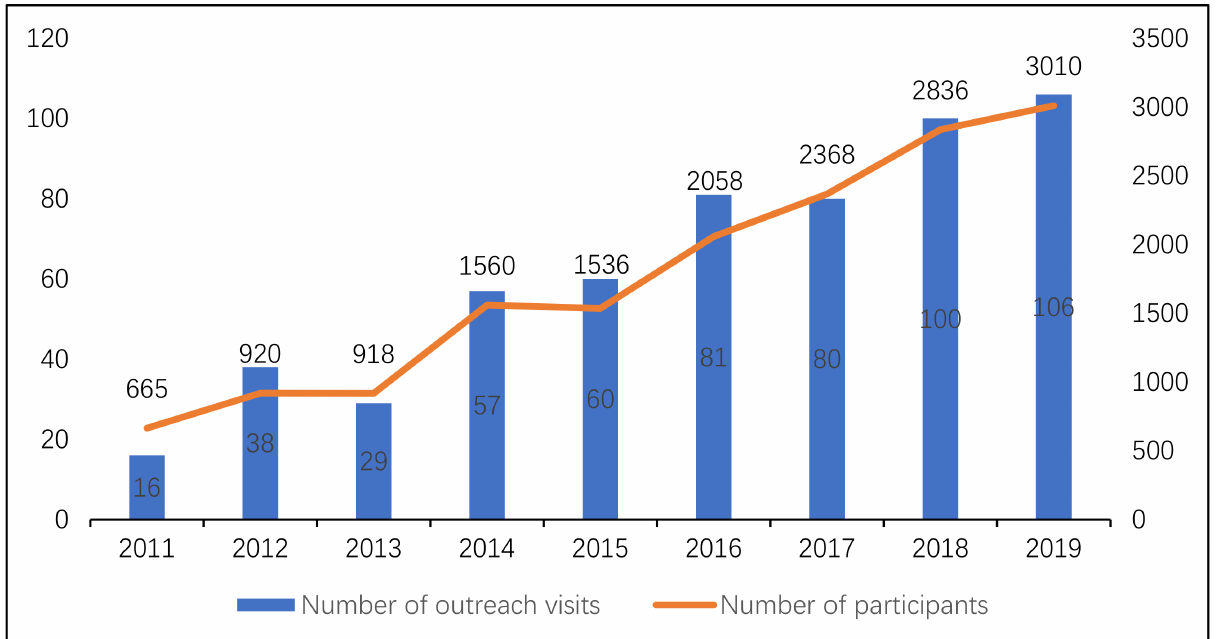
Figure 2. Number of outreach visits and number of participants during each